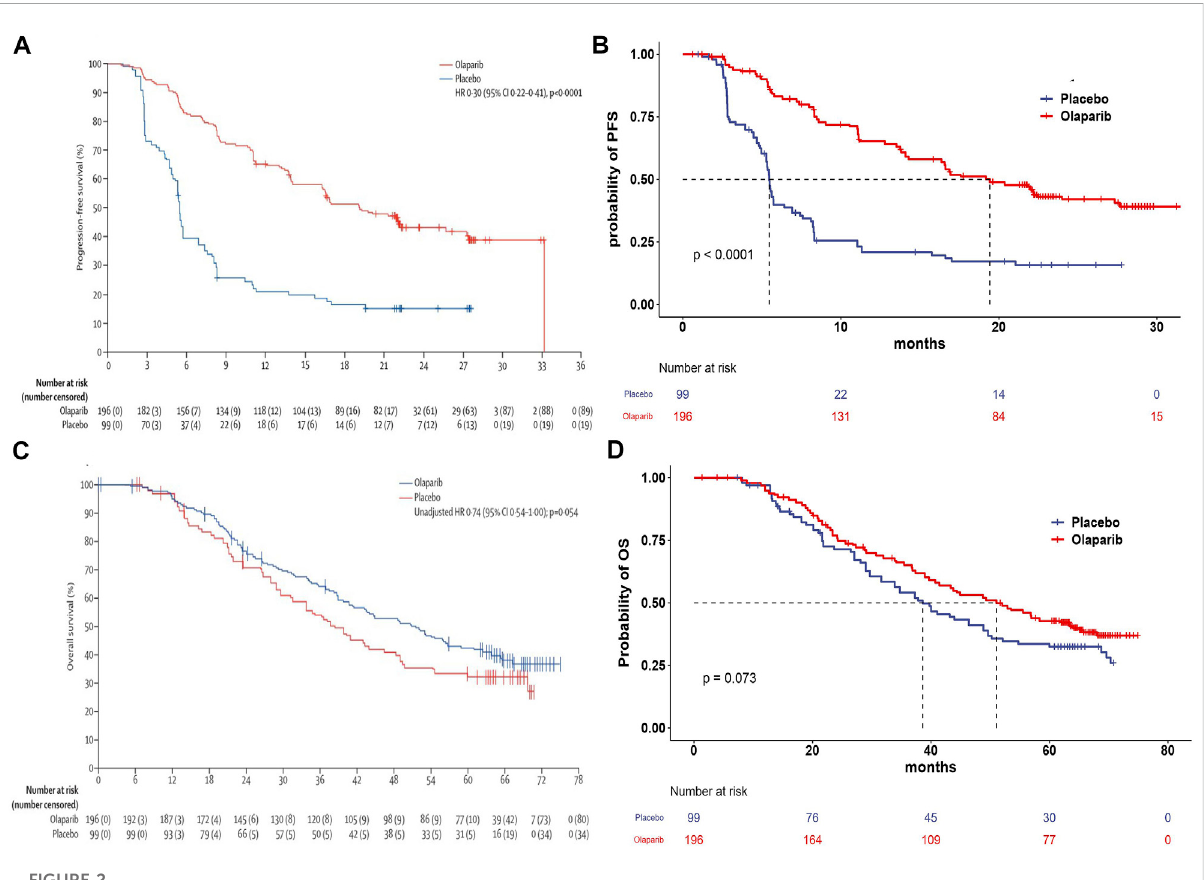
FIGURE 2 (A) Kaplan – Meier curve of progression-free survival from the SOLO2 trial. (B) Simulate progression-free survival curve for the olaparib and the placebo group. (C) Kaplan – Meier curve of the overall survival from the SOLO2 trial. (D) Simulate overall survival curve for the olaparib group and the placebo group. Abbreviations: OS, overall survival; PFS, progression-free